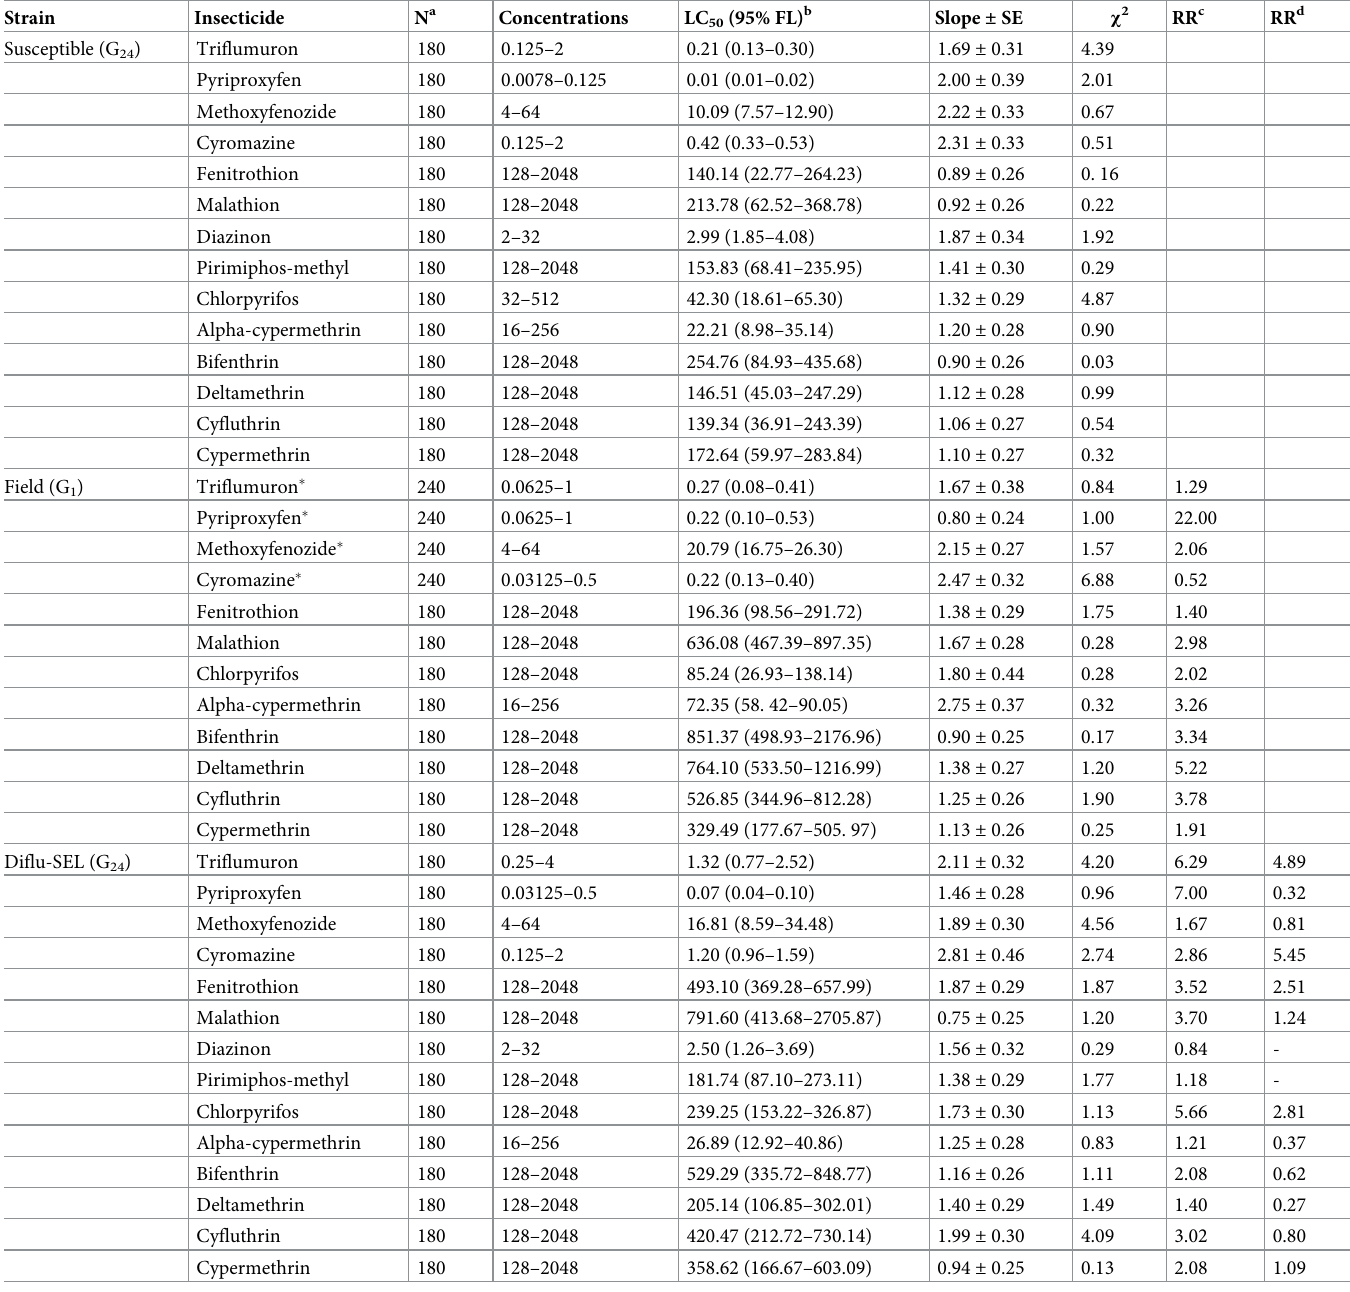
Table 5. Cross-resistance to fourteen other insecticides in the diflubenzuron-selected strain of M . domestica .